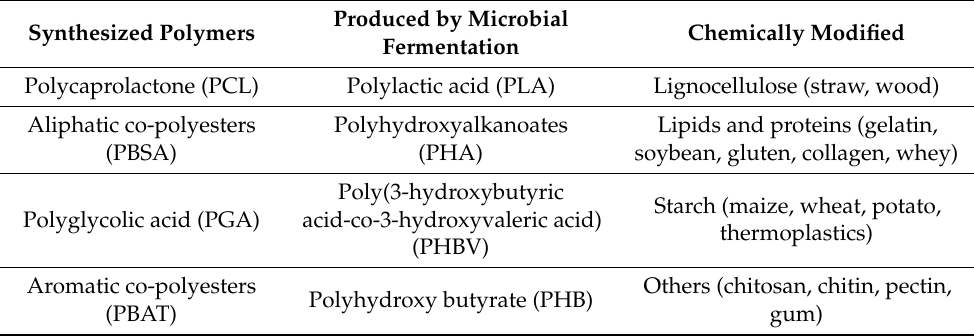
Table 1. Typically known biopolymers [10–12]. Synthesized